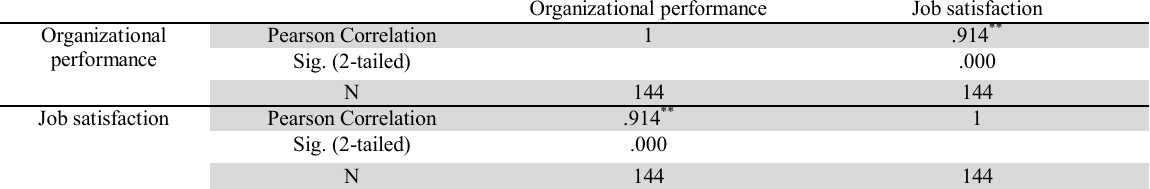
The results of relationship between job satisfaction and organizational performance Organizational performance Job satisfaction Organizational Pearson Correlation 1 .914 ** performance Sig. (2-tailed) .000 N 144 144 Job satisfaction Pearson Correlation .914 ** 1 Sig. (2-tailed) .000 N 144